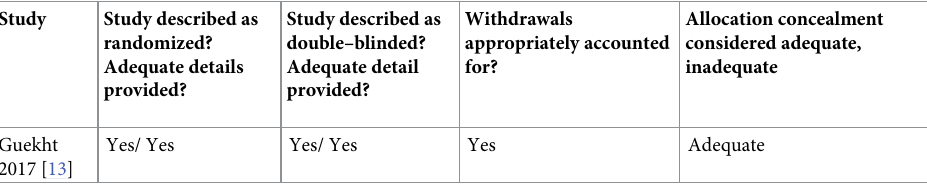
Table 5. Quality assessment of the included randomized trials using the Jadad